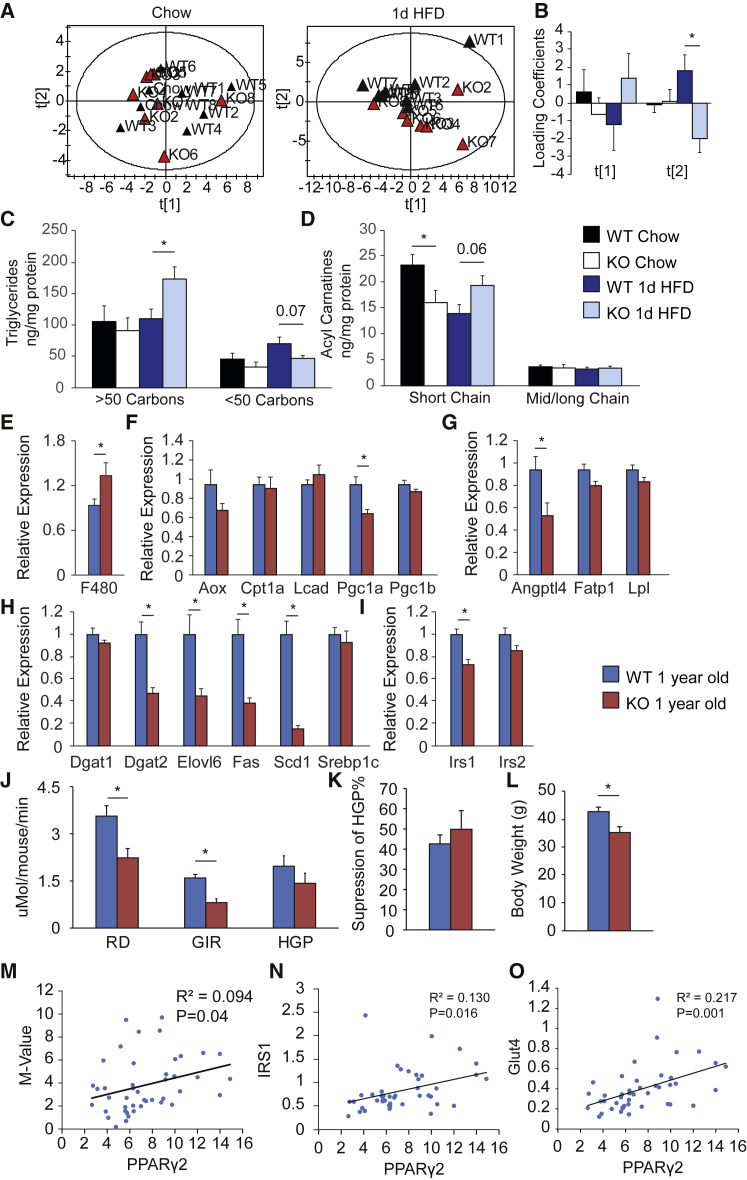
Loss of Adipose Tissue Lipid Buffering Leads to Aging-Related Insulin Resistance(A) Principal-component analysis of lipid species from muscle of chow (left) or 1dHFD (right) fed mice.(B) Quantification of the first two principal components from (A).(C) Muscle TG species.(D) Muscle acylcarnitines species (n = 6–8 per group).(E–I) Gene expression in muscle of 1-year-old mice: (E) F4/80, (F) FA oxidative markers, (G) lipid uptake and storage genes, (H) lipid biosynthetic genes, and (I) Insulin sensitivity markers (n = 10 WT, n = 7 KO, male mice chow fed).(J–L) Clamps from 1-year-old mice: (J) rate of glucose disposal (RD), glucose infusion rate (GIR), and hepatic glucose production (HGP) under hyperinsulinemic condition; (K) suppression of HGP between the basal and hyperinsulinemic state; and (L) body weights of mice used for clamps (n = 7 WT and 6 KO mice, chow fed).(M–O) Correlations between PPARγ2 expression in human scWAT and (M) M-value during a clamp, (N) IRS1 expression, and (O) Glut 4 expression (n = 45 subjects).For multiple time points, two-way ANOVA was performed, and if significant, pairwise comparisons were performed using two-tailed Student’s t test (∗p < 0.05). Correlations are Pearson’s, and exact p values are reported. All mice were 4–5 months old. All data are represented as mean ± SEM. See also Figures S3 and S4.